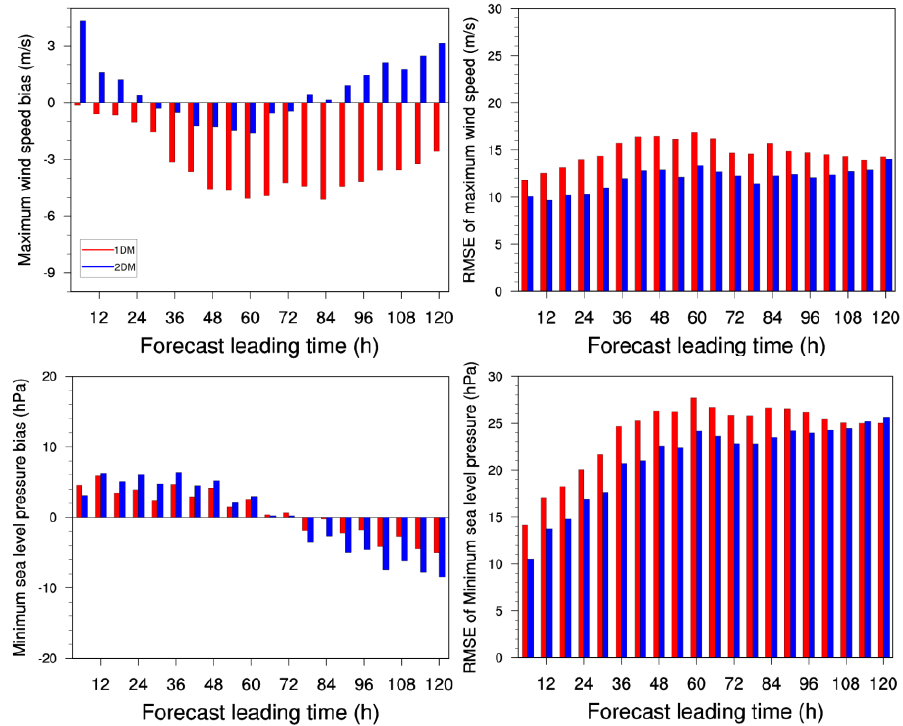
Figure 1. Bias (left) and RMSE (right) of the maximum wind speed (MWS) and minimum sea level pressure (MSLP) for the 1DM and 2DM experiments.